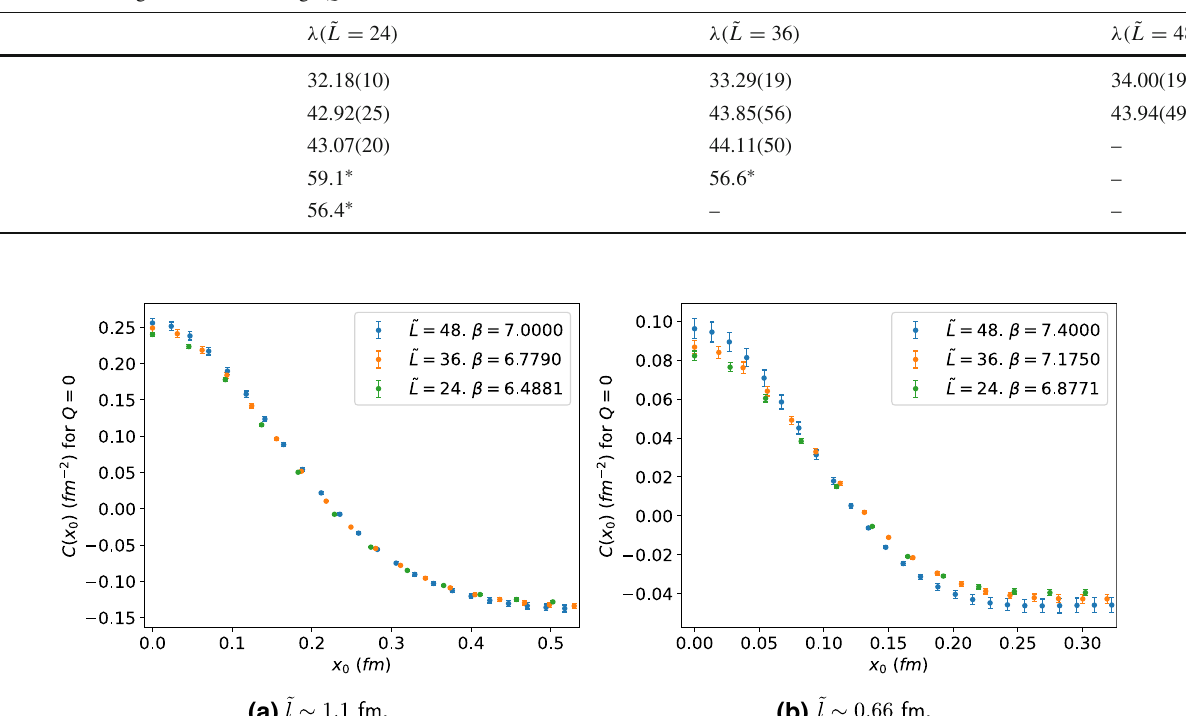
Table 5 Values of the TGF coupling measured on sectors with fixed value of the topological charge Q . Entries with a ∗ correspond to cases where the number of configurations with charge Q is less than 20 and a correct estimation of errors is not viable